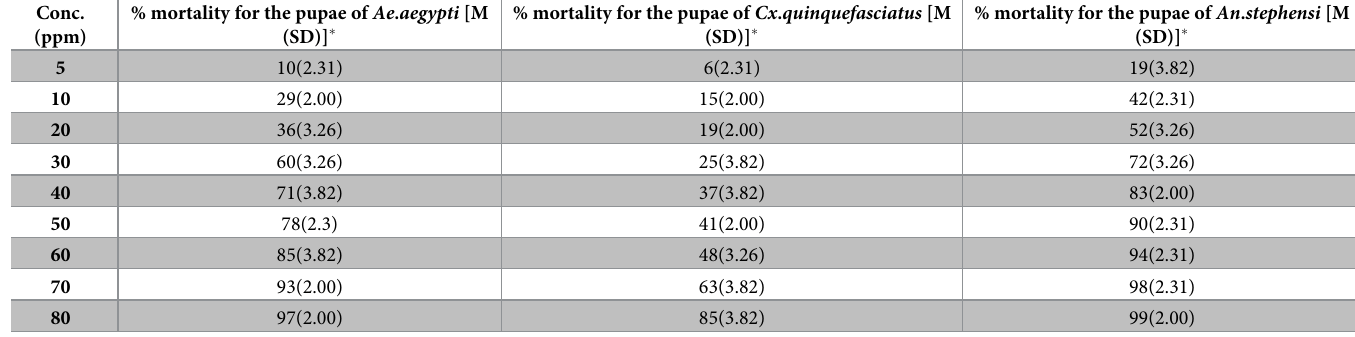
� Mean(Standard Deviation).